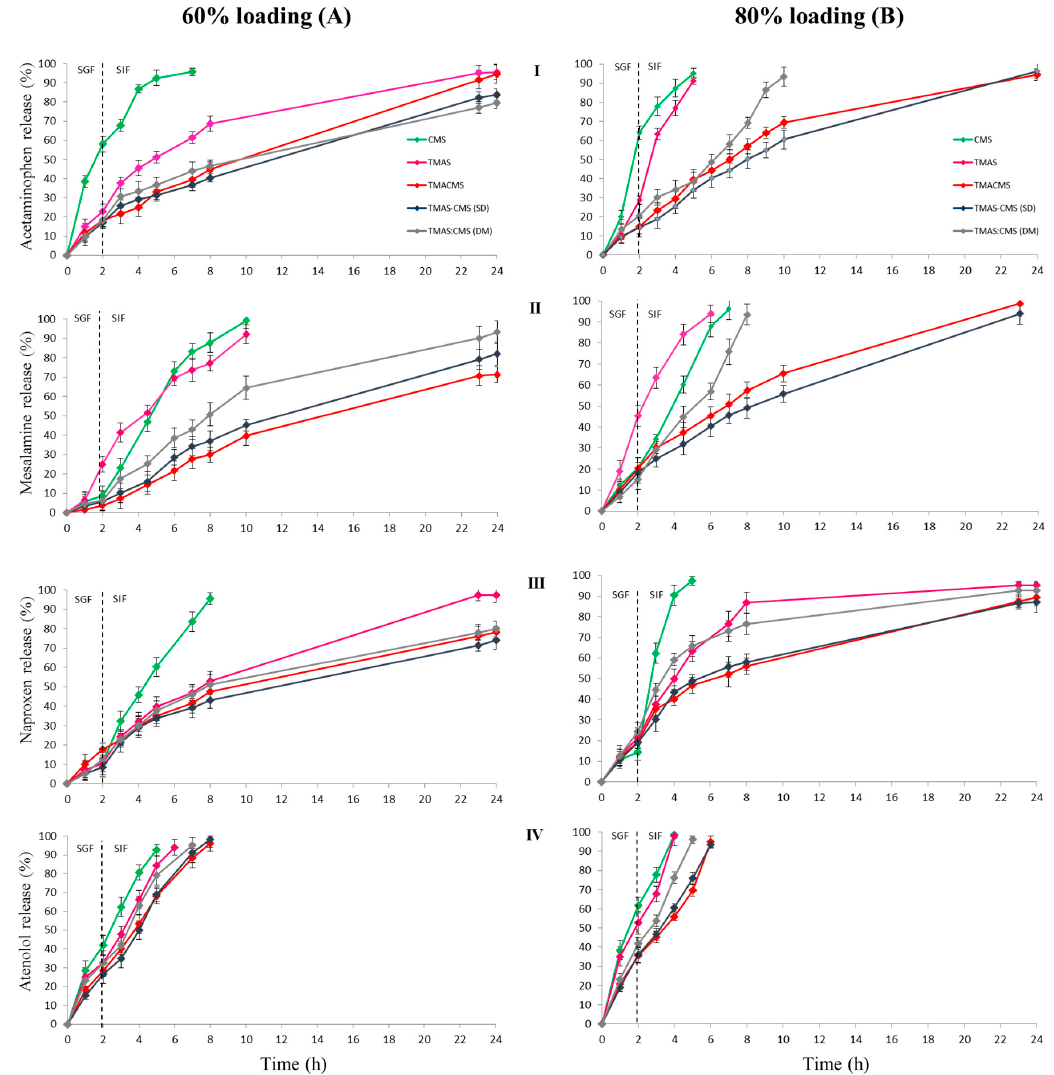
Figure 7. Release profiles of 60% ( A ) and of 80% ( B ) loaded tablets with: acetaminophen (I), mesalamine (II), naproxen (III), and atenolol (IV). The tablets were immersed for 2 h in simulated gastric fluid (SGF) and then transferred to simulated intestinal fluid (SIF).